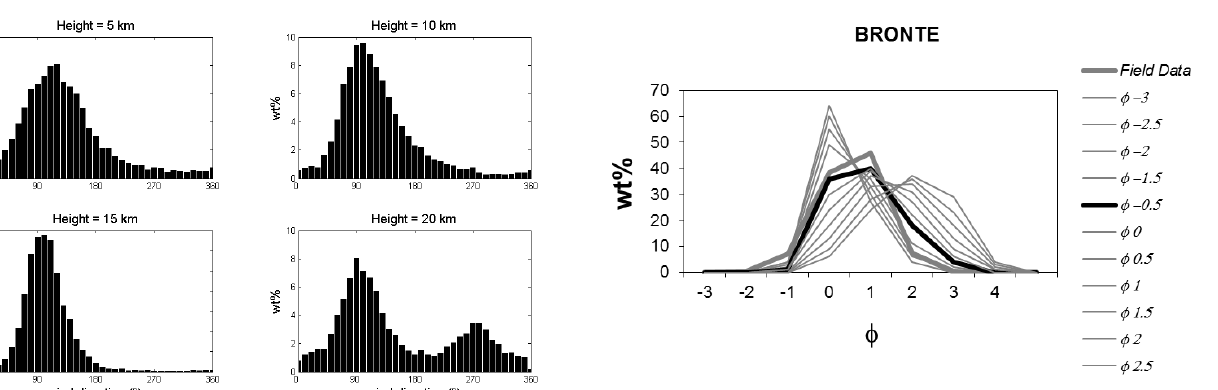
Fig. 7. Plots showing the percentage of wind direction between 0 ◦ Figure 7. Plots showing the percentage of wind direction between 0 and 360° (from the North) 651 and 360 ◦ (from the north) at four different altitude levels (i.e. 5, 10, at four different altitude levels (i.e. 5, 10, 15 and 20 km). Data are available at 652 15 and 20km). Data are available at http://weather.uwyo.edu. http://weather.uwyo.edu. 653